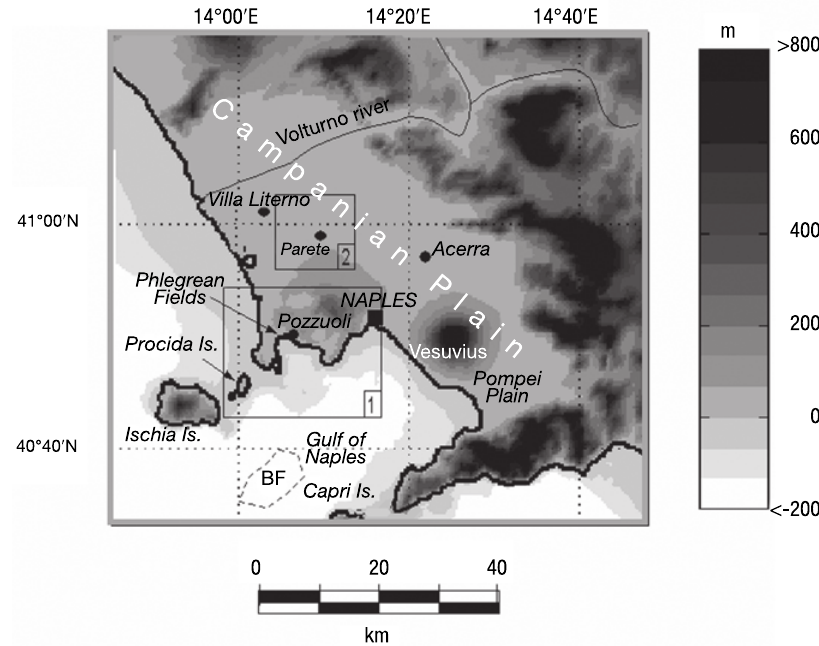
Fig. 1. Regional sketch map of the Campanian Plain (Southern Italy). Windowed areas indicate sectors specifically investigated: 1) Phlegrean Fields-Gulf of Pozzuoli; 2) Parete area. Gray shading represents topography (darker colors = higher values). Coordinates UTM, zone